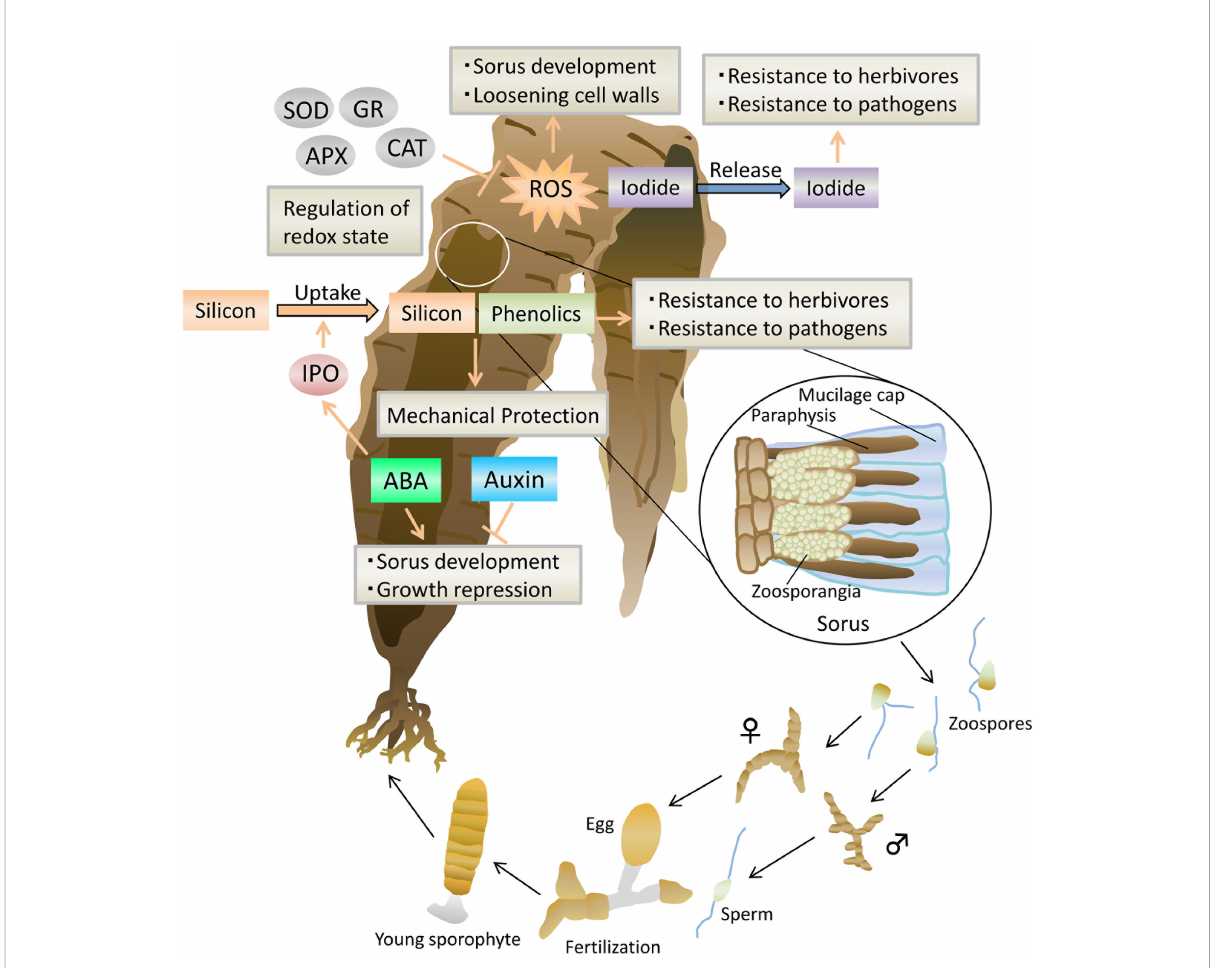
FIGURE 1 Model of the defense system during sorus development in Saccharina japonica. Arrows represent positive regulation, and blocked arrows represent negative regulation. ABA, abscisic acid; ROS, reactive oxygen species; IPO, iodoperoxidase; APX, ascorbate peroxidase; CAT, catalase; SOD, superoxide dismutase; GR, glutathione